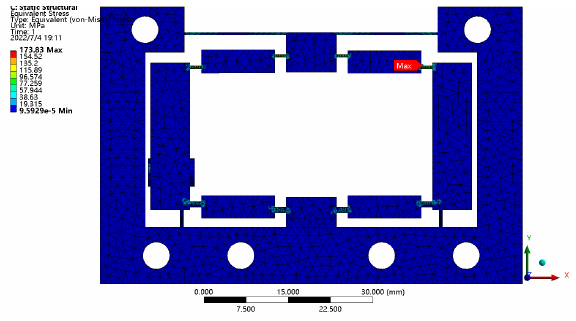
Figure 12. Schematic of the HBLB.